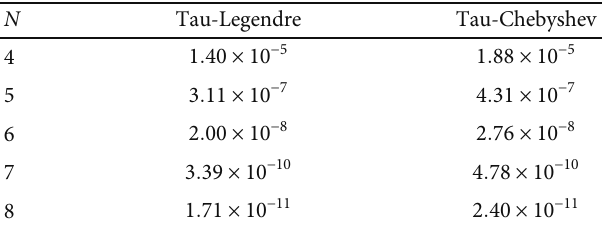
Table 3: L 2 w errors of the operational Tau methods for Example 2. N